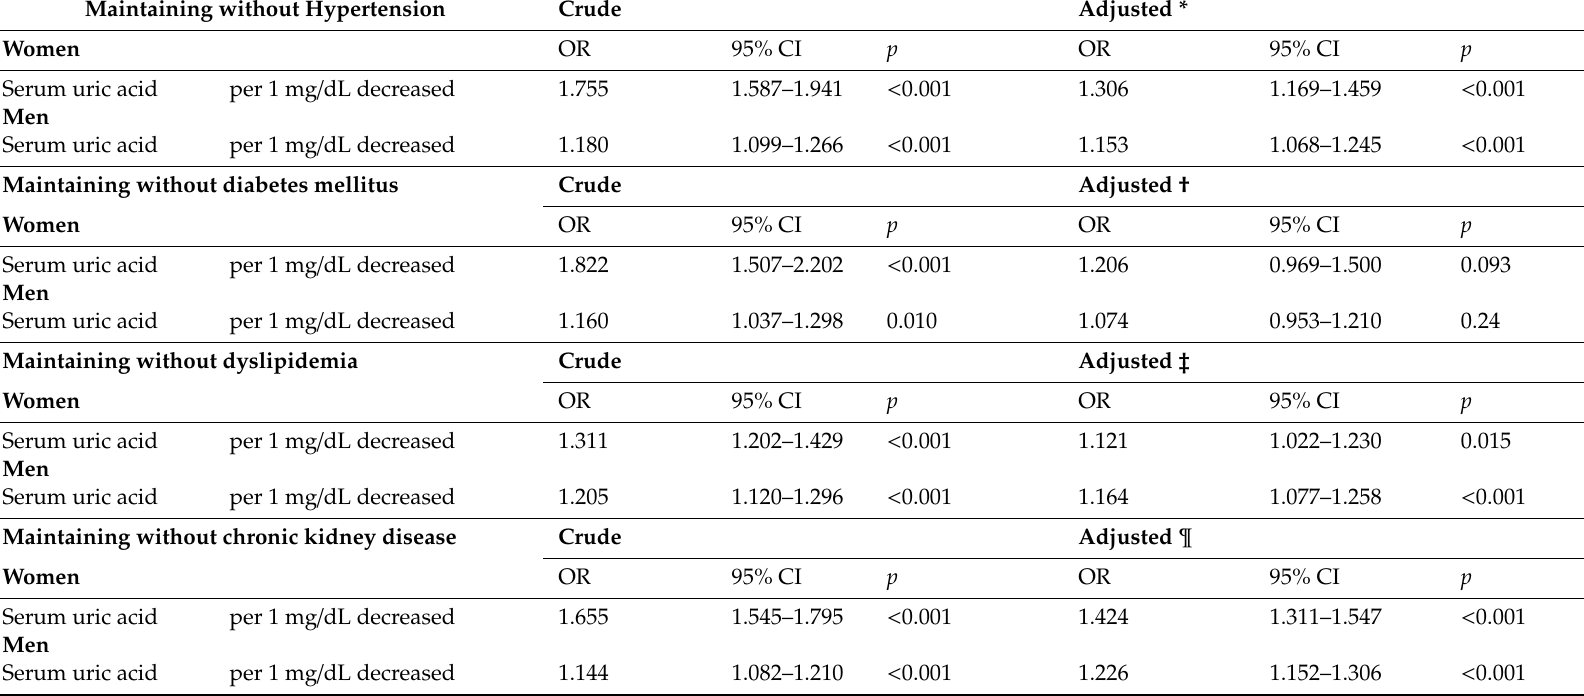
Table 2. Lower serum urate as a protective factor for the development of hypertension, diabetes, dyslipidemia and chronic kidney disease over 5